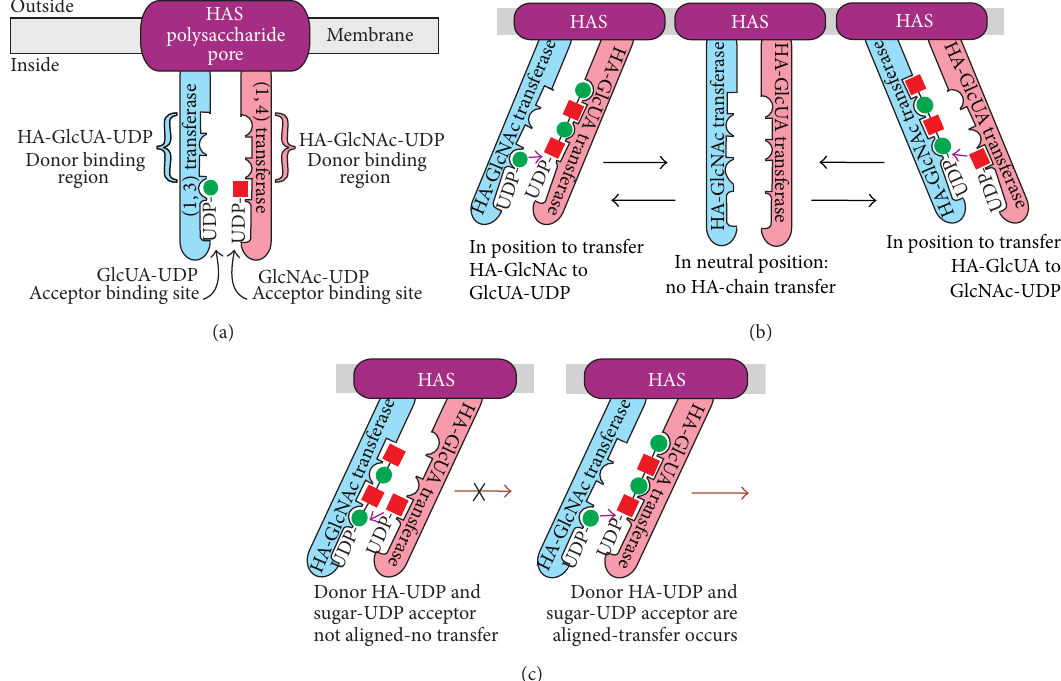
Figure 6: The Pendulum Model for HAS Translocation of HA. (a) Organization of hyaluronyl transferase domains and glycosyl-UDP binding sites within HAS. The scheme shows the cell membrane (gray) and three overall domains of the HAS ⋅ lipid complex: a pore region (purple) containing HAS MDs through which a growing HA chain is passed to the exterior, and two catalytic domains that behave as swinging arms (blue and pink). Each arm contains one of the two functional hyaluronyl transferase activities and binding sites needed to add either an HA-GlcUA-UDP donor chain to GlcNAc-UDP [left arm (blue); the 𝛽 (1,3)-hyaluronyl transferase] or an HA-GlcNAc-UDP donor chain to GlcUA-UDP [right arm (pink); the 𝛽 (1,4)-hyaluronyl transferase]. The figure also illustrates that an individual sugar-UDP binding site is part of the HA-UDP binding site on each arm. (b) The interactions between the glycosyl-UDP binding sites and hyaluronyl transferase domains change as the domain arms move. The three positions, from left to right, indicate three conformations in which HAS is either able to create the GlcNAc 𝛽 (1,4)GlcUA bond, unable to perform either transferase function, or able to create the GlcUA 𝛽 (1,3)GlcNAc bond. The left and right positions also illustrate that when the enzyme is in position to catalyze one of the transferase reactions, the growing HA chain is bound primarily to one arm, whereas the sugar-UDP substrate is bound to the other arm. In the central panel, a neutral or inactive position, the individual sugar binding sites in the HA-binding region on each arm are “misaligned” so that they are unable to bind HA at the same time. (c) HAShyaluronyltransferaseactivitiesrequirecorrectalignmentbetweentheglycosyl-UDPbindingsitesonoppositedomainarms.Transferase function depends on howthe two armsare aligned with respect to theability to bind substrates or to perform catalysis. The relative positioning of HA-UDP and sugar-UDP binding sites are shown with the complementary glycosyl-UDP substrates bound incorrectly and not aligned for creating a glycoside bond (left) or with the right substrates bound and aligned correctly for successful -GlcNAc- 𝛽 (1,4)-GlcUA-bond formation